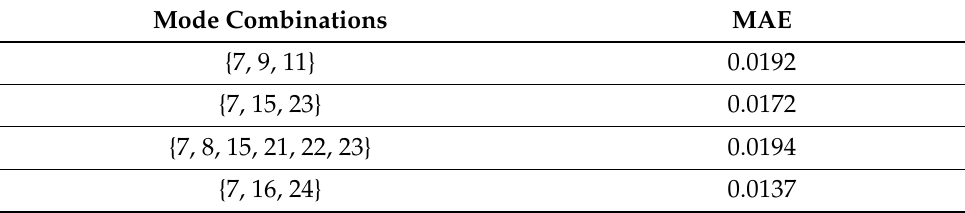
Table 2. The mean absolute errors (MAE) and VAE performance compared to